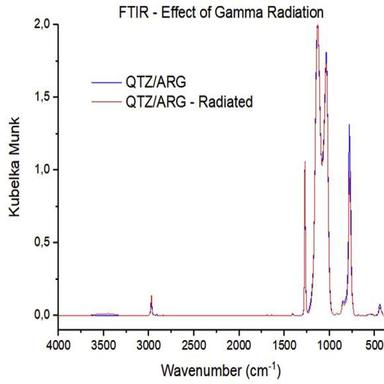
FTIR of QTZ/ARG before and after gamma radiation exposure.